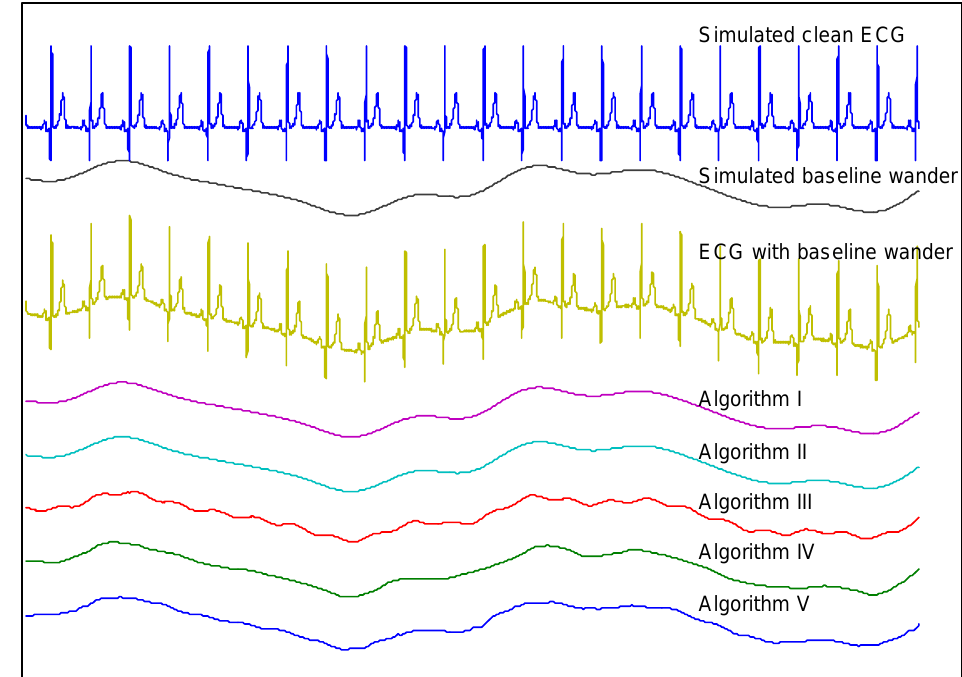
Figure 8. Comparison of estimated BW using five algorithms using the simulated ECG and BW.